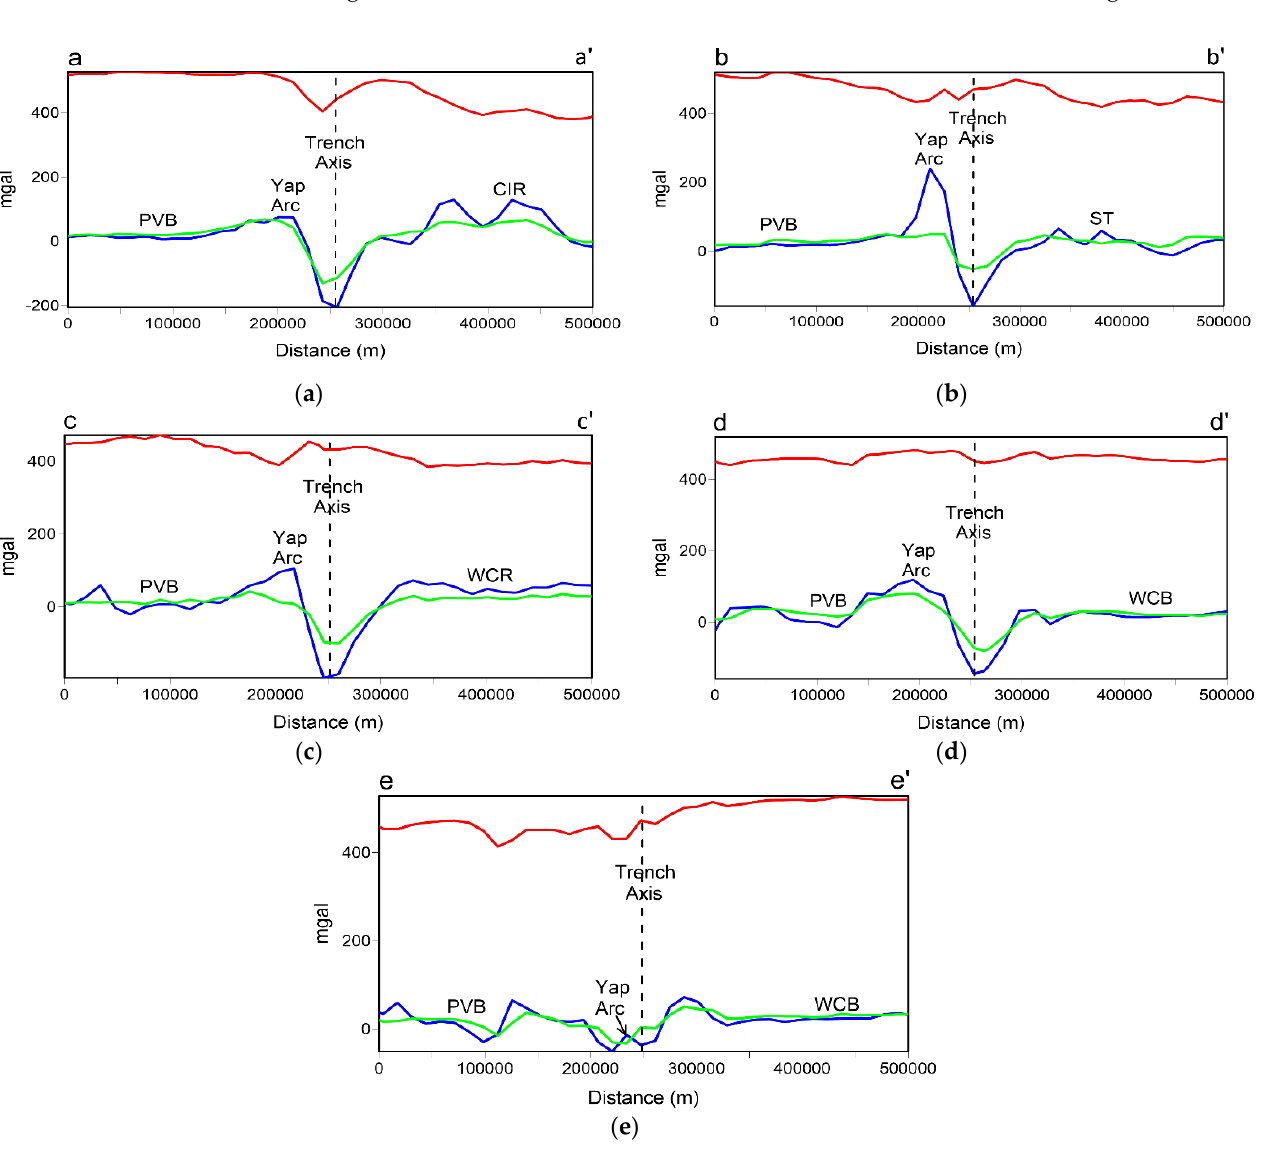
Figure 9. The gravity anomaly fields across the southernmost Parece Vela Basin, Yap arc, arc-ward trench slope, Yap Trench axis, and sea-ward trench slope in inter-relationship with the CR subduction (Red = Bouguer gravity anomaly, Blue = free-air gravity anomaly, Green = isostatic gravity anomaly). ( a ) Profile aa’; ( b ) Profile bb’; ( c ) Profile cc’; ( d ) Profile dd’; ( e ) Profile ee’. Gravitational anomaly profiles aa’, bb’, and cc’ are extracted from the line segments aa’, bb’, and cc’ north of 8°26 ′ N, respectively, and profiles dd’ and ee’ are extracted from line segments dd’ and ee’ south of 8°26 ′ N, respectively. See Figure 1 for the location of the line segments, aa’, bb’, cc’, dd’, and ee’, and the abbreviations.